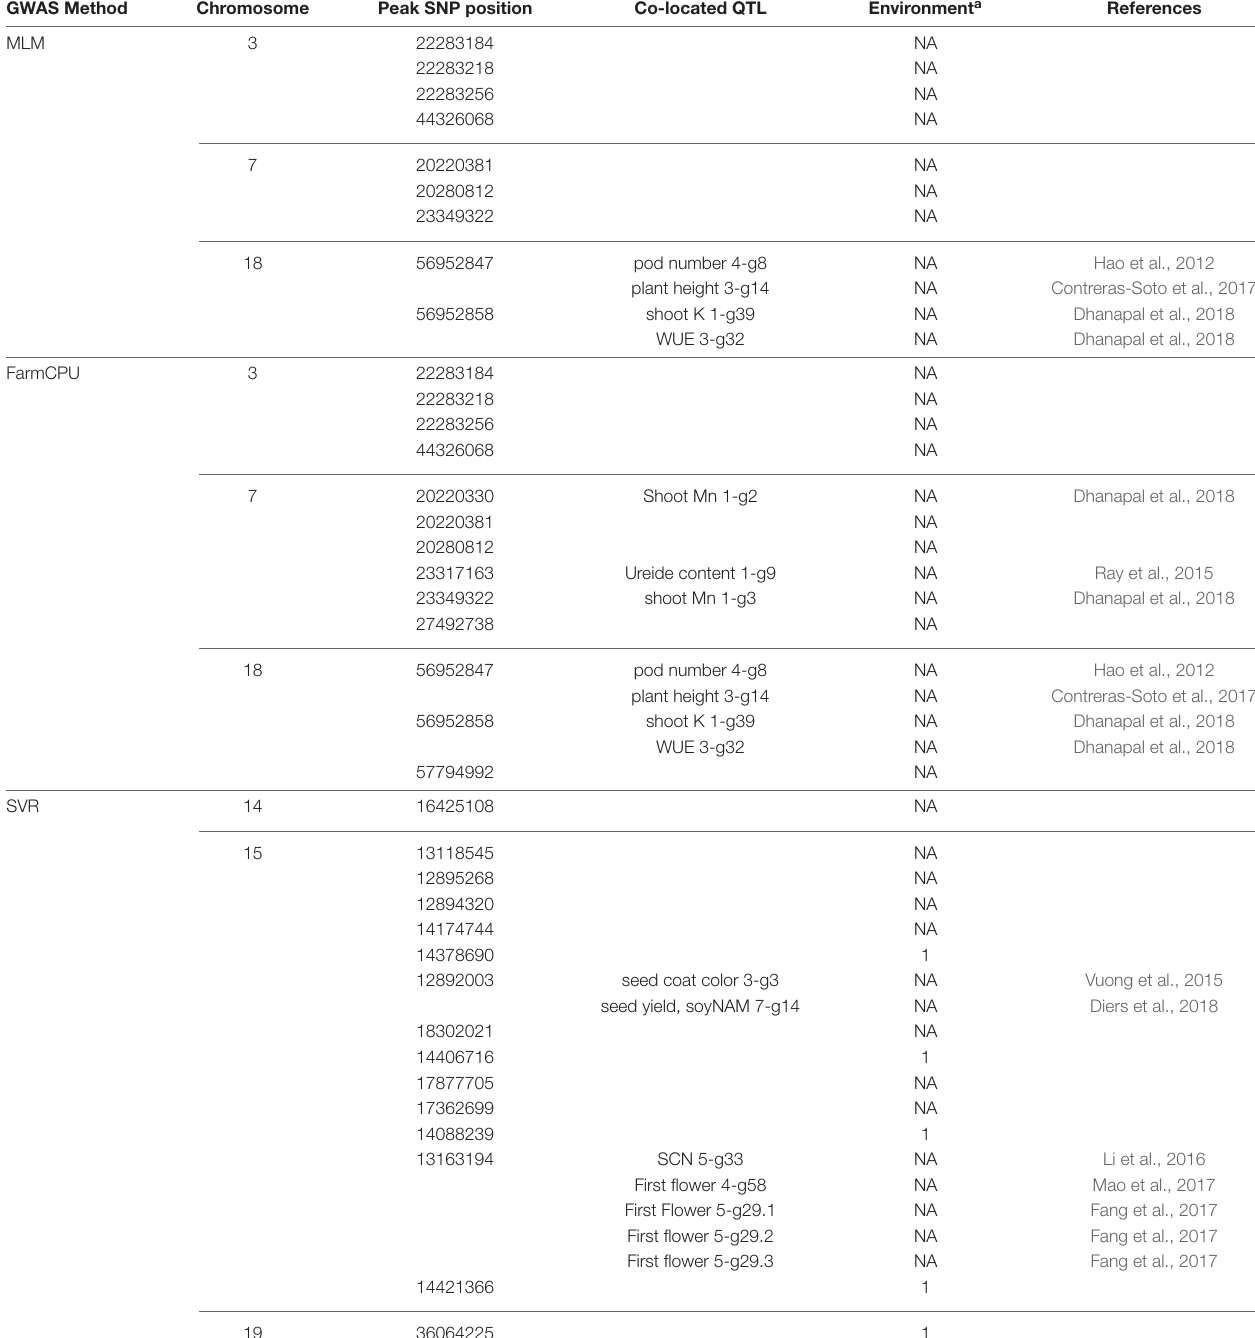
TABLE 3 | The list of detected QTLs for 660 nm using different GWAS methods in the tested soybean panel. GWAS Method Chromosome Peak SNP